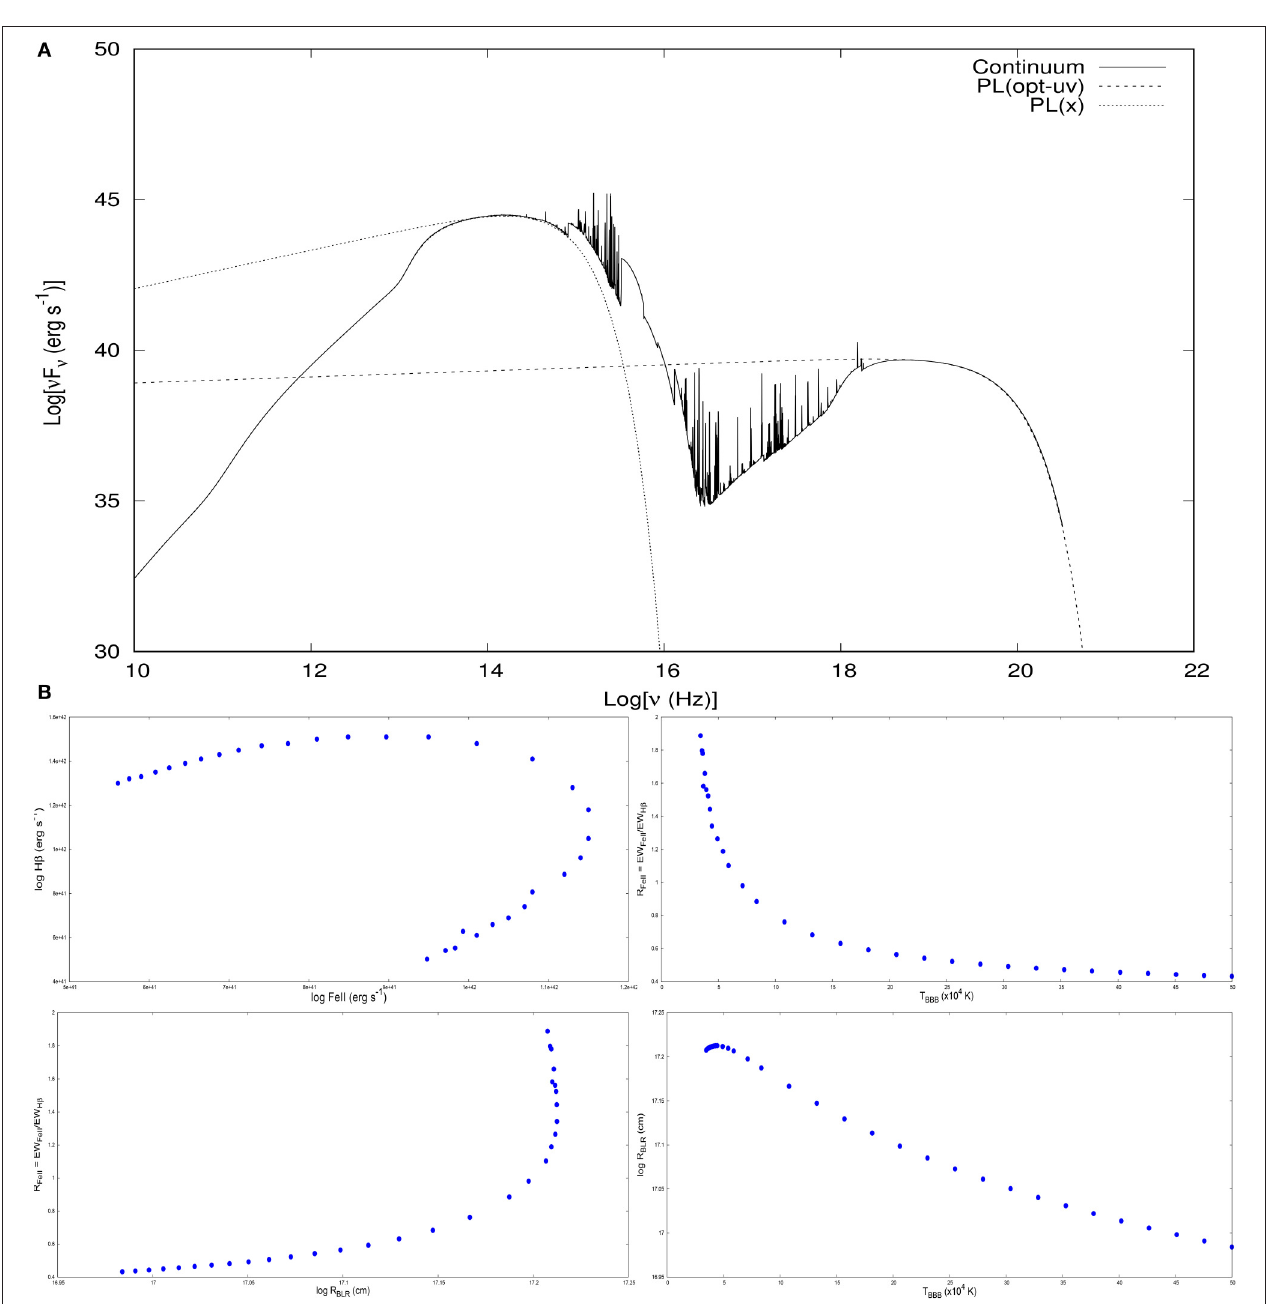
FIGURE 1 | (A) An example of the spectral energy distribution of the AGN transmitted continuum and line emission produced by CLOUDY: T BBB = 3.45 × 10 4 K, α ox = − 1.6, α uv = − 0.36, α x = − 0.9, n H = 10 11 cm − 3 , N H = 10 24 cm − 2 and log radiation. (B) The family of solutions is parameterized by maximum accretion disk temperature: (i) composite Fe II line luminosity [erg s − 1 ] − H β line luminosity [erg s − 1 ]; (ii) T BBB − R FeII ; (iii) log R BLR − R FeII ; (iv) T BBB − log R BLR . Trends plotted for the following values of the parameters: L bol = 10 45 erg s − 1 , n H = 10 11 cm − 3 and N H = 10 24 cm − 2